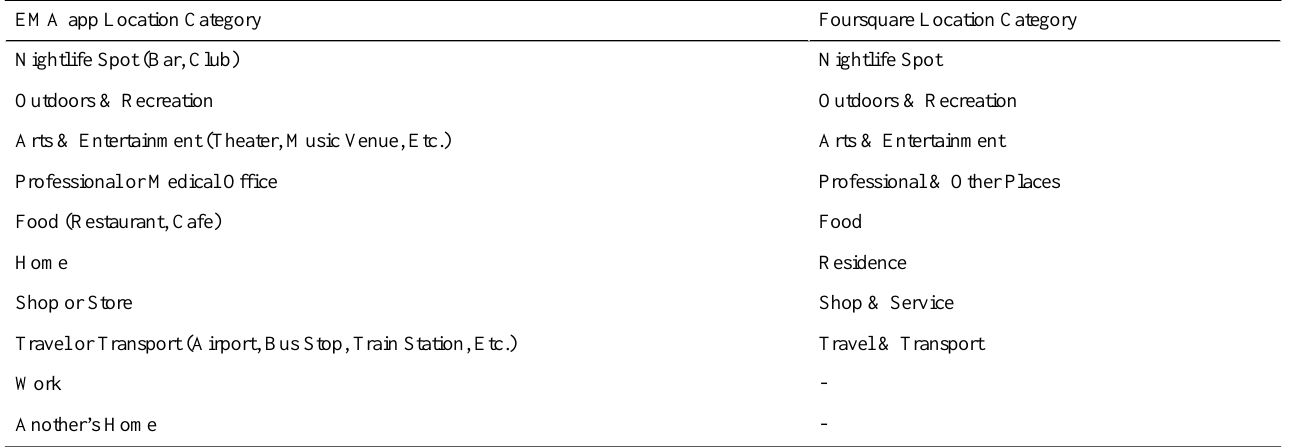
Table 1. Location category labels reported by our study participants (left) and their corresponding high-level Foursquare location